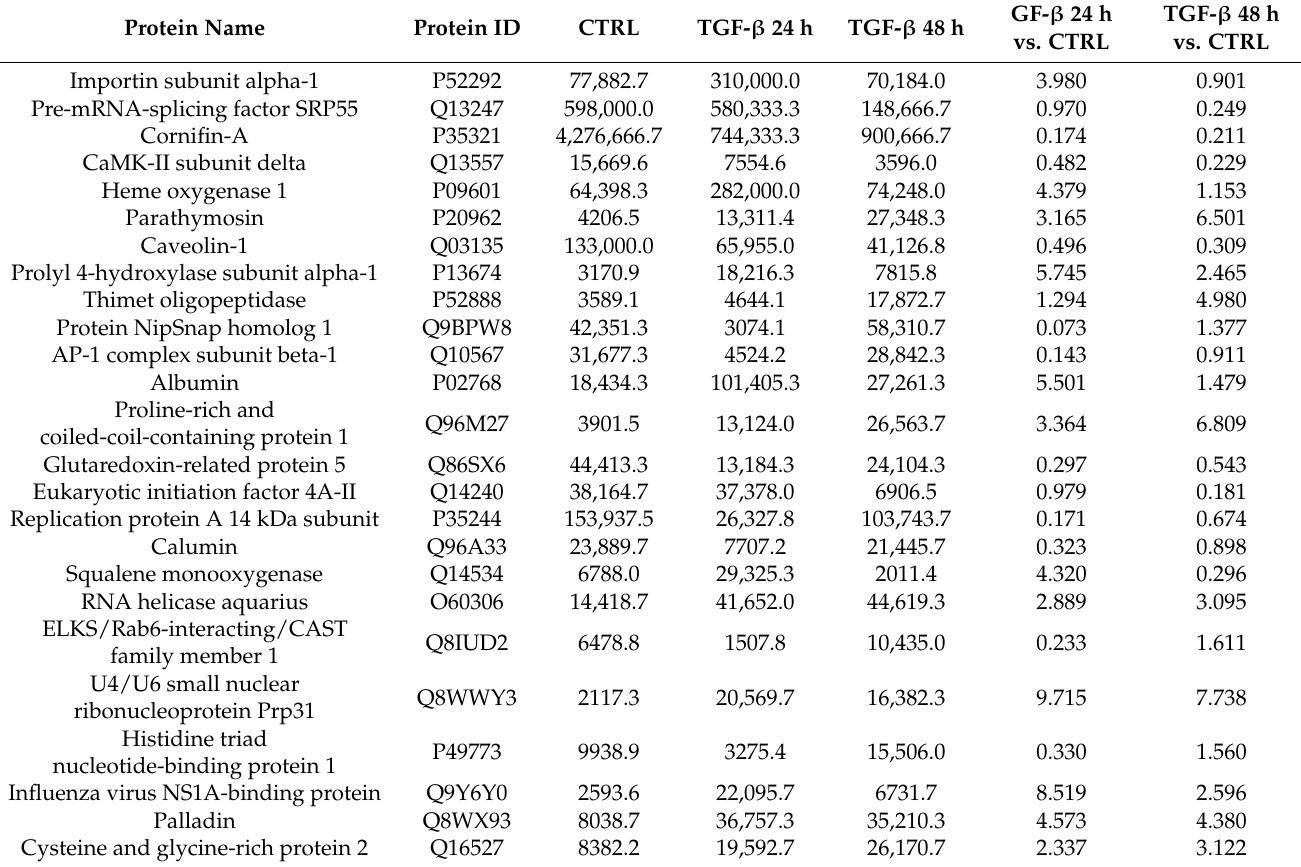
Table 1. Identified differentially expressed proteins in TGF-β-treated cholangiocytes. The table be- low reports mean protein abundances and degrees of variation (evaluated as fold change) with re- spect to the control for TGF-β-treated cholangiocytes at 24 h and 48 h.